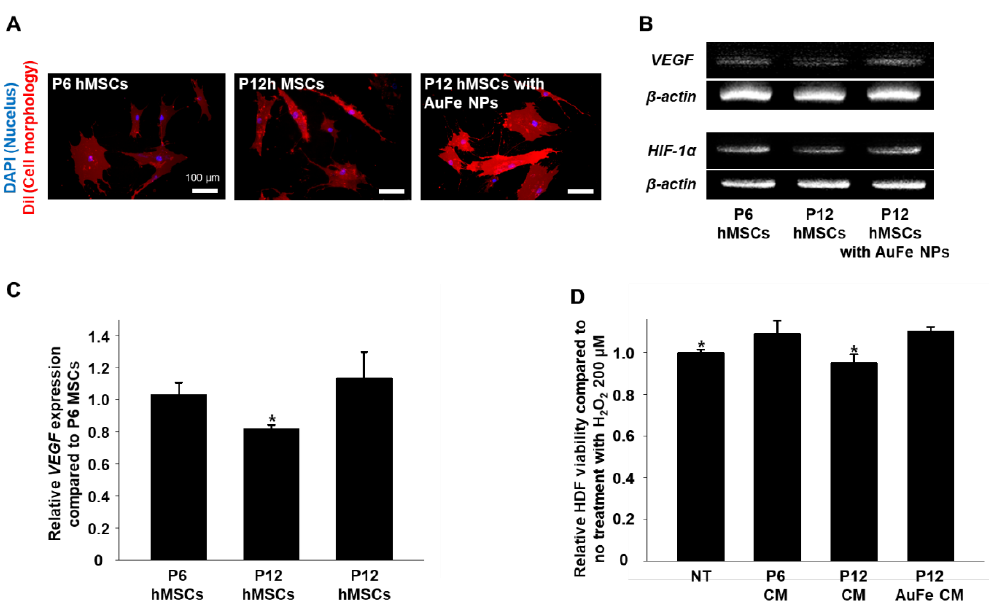
Figure 3. ( A ) DiI staining (blue: nucleus, red: cellular membrane) of hMSCs with low passage (P6) without NP treatment, hMSCs with high passage (P12) without AuFe NP treatment, and hMSCs with high passage (P12) with AuFe NP treatment. ( B ) VEGF and HIF-1 α expression in P6 hMSCs without NP treatment and P12 hMSCs without or with AuFe NP treatment, as evaluated by RT-PCR. ( C ) Relative VEGF expression in P12 hMSCs without or with AuFe NP treatment, with respect to that in P6 hMSCs without NP treatment ( n = 4, * p < 0.05 versus P12 hMSCs with AuFe NPs group). ( D ) Relative cell viability of human dermal fibroblasts (HDFs) cultured using CM collected from NT; Fresh medium, P6 CM; P6 hMSCs without NP treatment, P12 CM; P12 hMSCs without NP treatment, and P12 AuFe CM; P12 hMSCs with NP treatment under hypoxic cinditions (H 2 O 2 , 200 µ M) ( n = 4, * p < 0.05 versus P12 AuFe CM group).